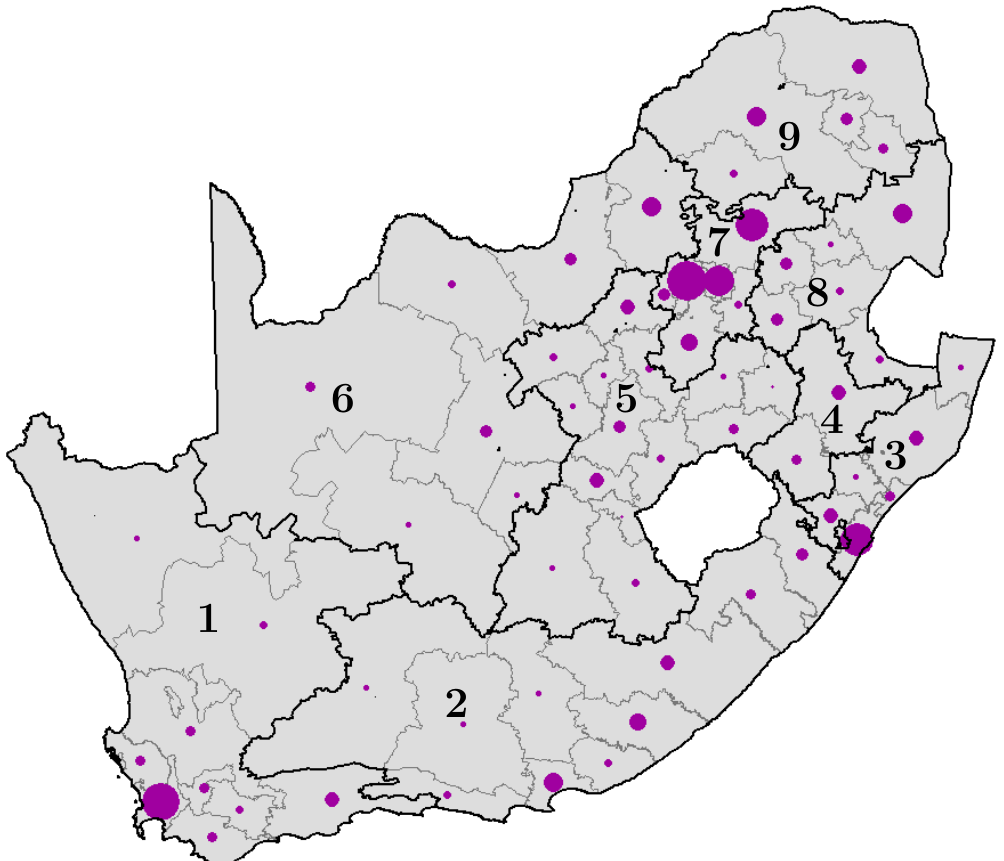
Figure 8: The remaining nine clusters with dots indicating the relative size of the intrazonal interaction per functional